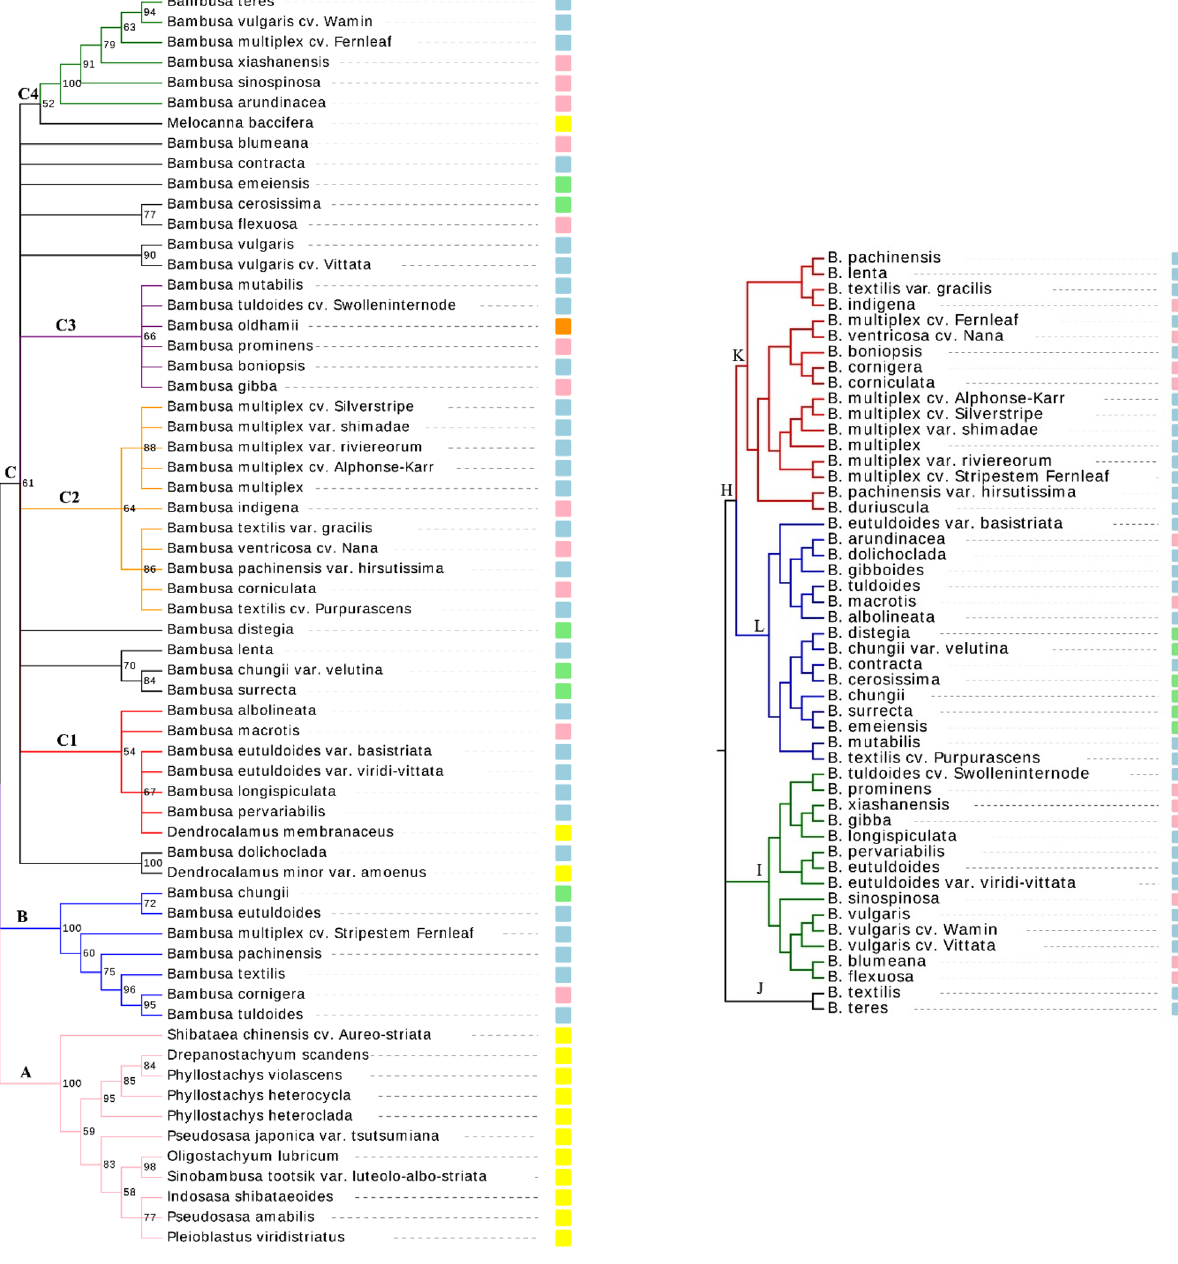
Figure 1. Strict consensus of the most parsimonious trees based on two cpDNA datasets (left), dendrogram derived from NJ cluster analysis based on 186 morphological descriptors of 50 bamboo species (right). Strips with different colors indicate subgenera: Lingnania (blue), Bambusa (pink), Leleba (green), Dendrocalamopsis (orange), and the outgroup